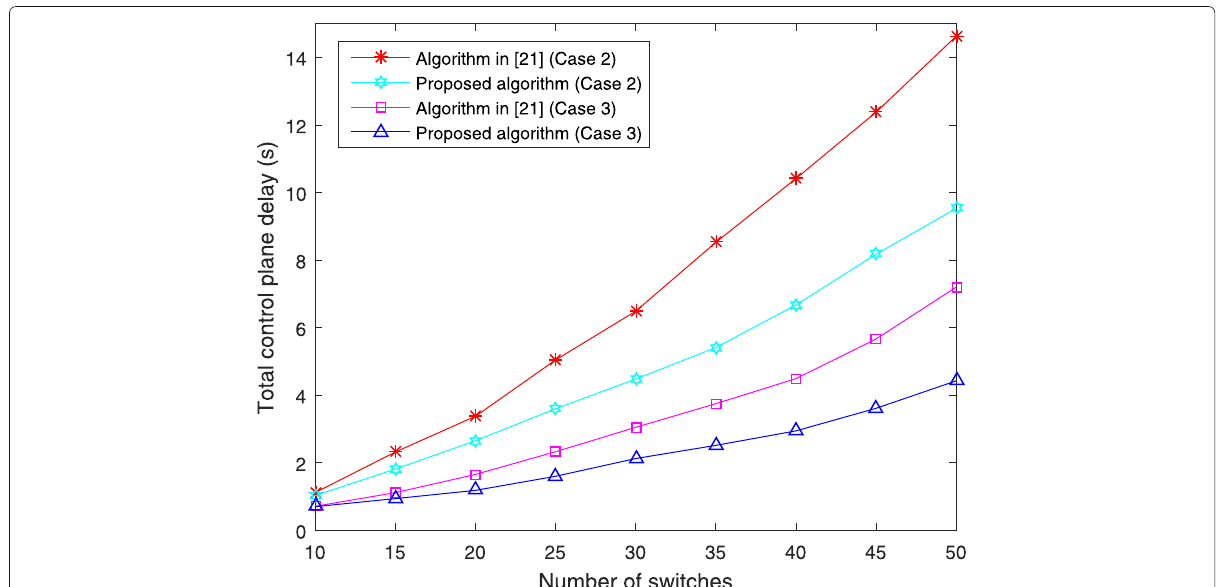
Fig. 7 Control plane delay versus the number of switches (different cases). The control plane delay versus the number of switches for different cases